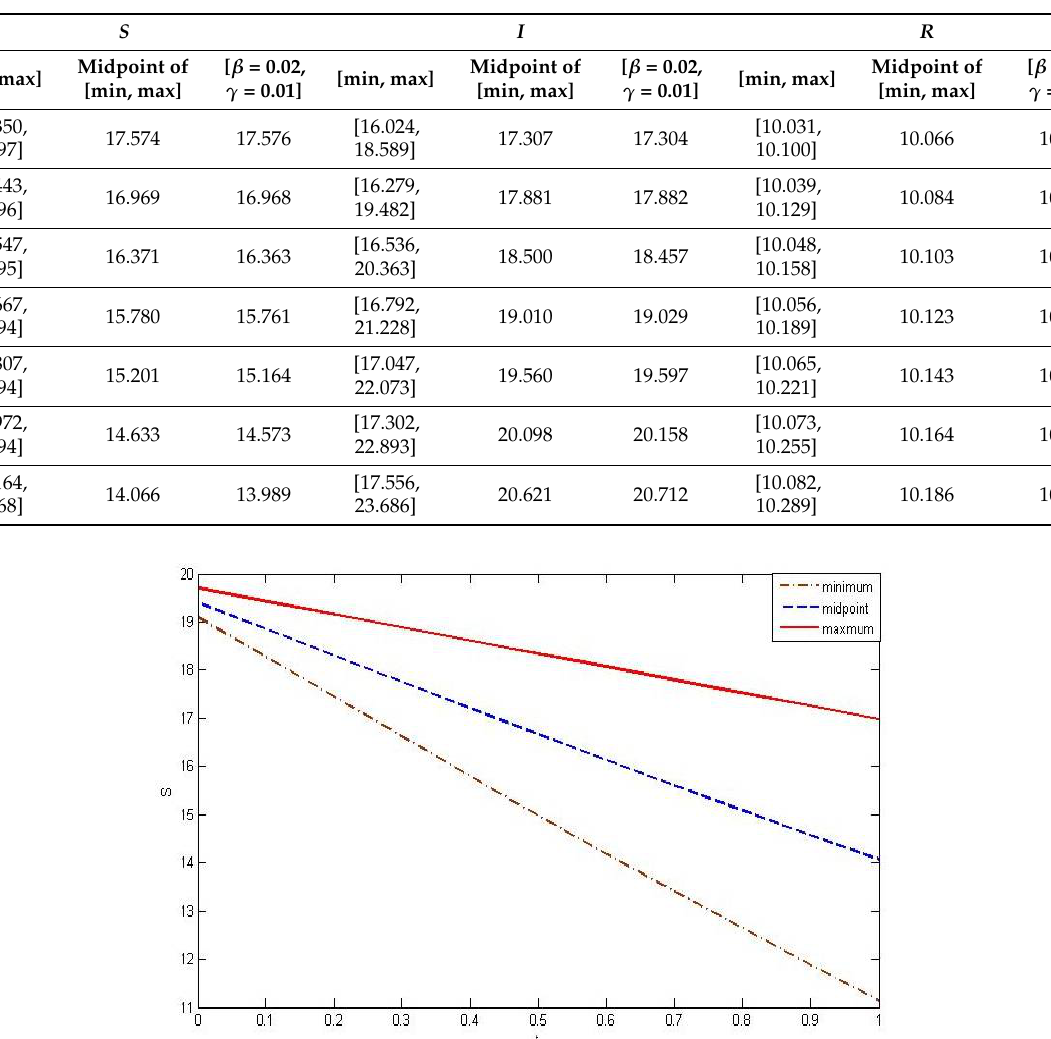
Figure A1. Plot of the maximum, center, and minimum of susceptible humana under the intervals